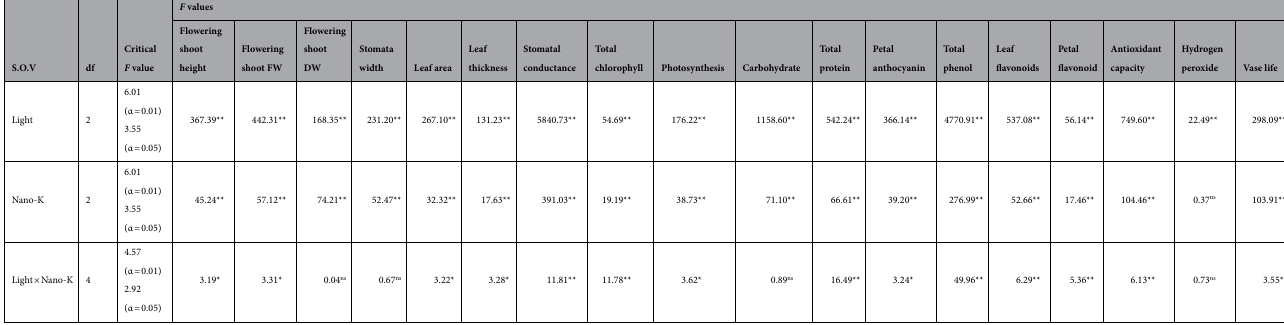
Table 2. Results of ANOVA table for measured traits due to light and nano-chelated potassium treatments. ns, *, **: Non-significant and significant at the probability level of 5% and 1%,